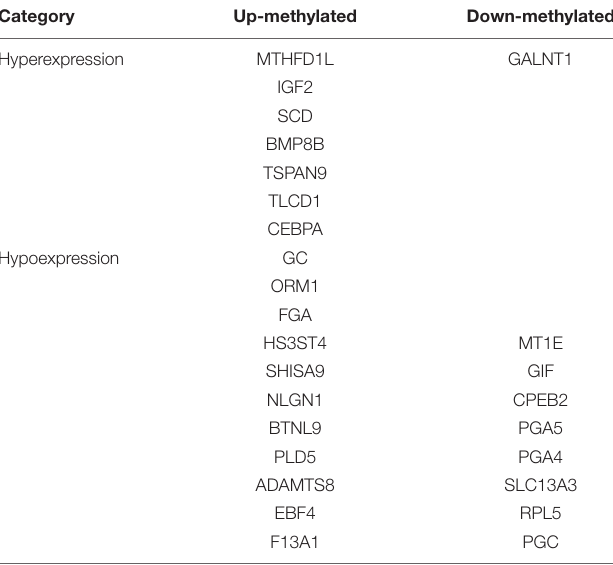
TABLE 3 | Gene and relationship between differential m6A methylation and gene expression